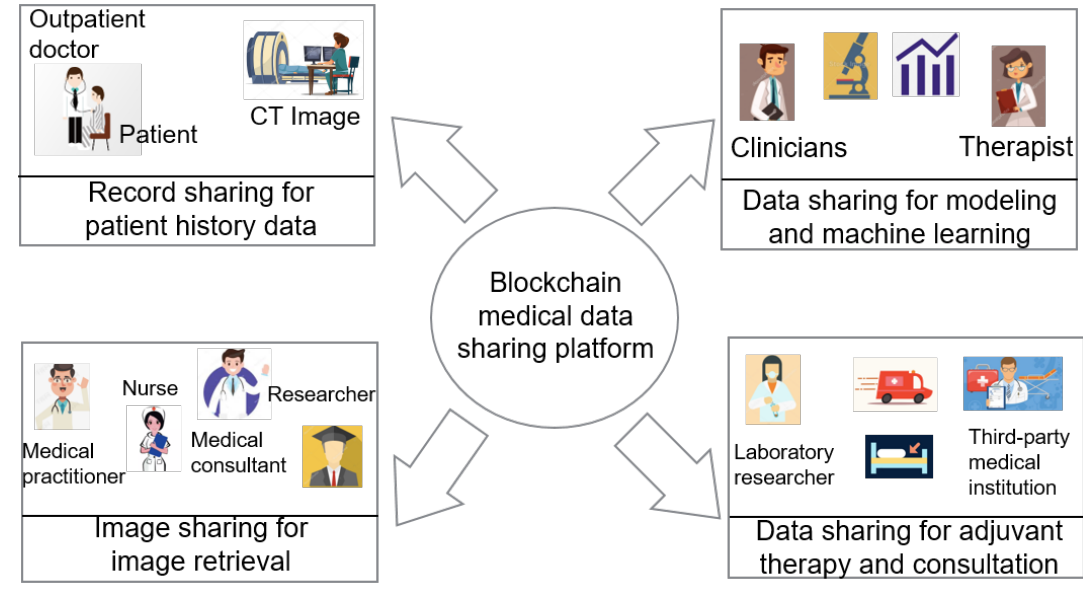
Figure 4. Potential applications of blockchain in the healthcare